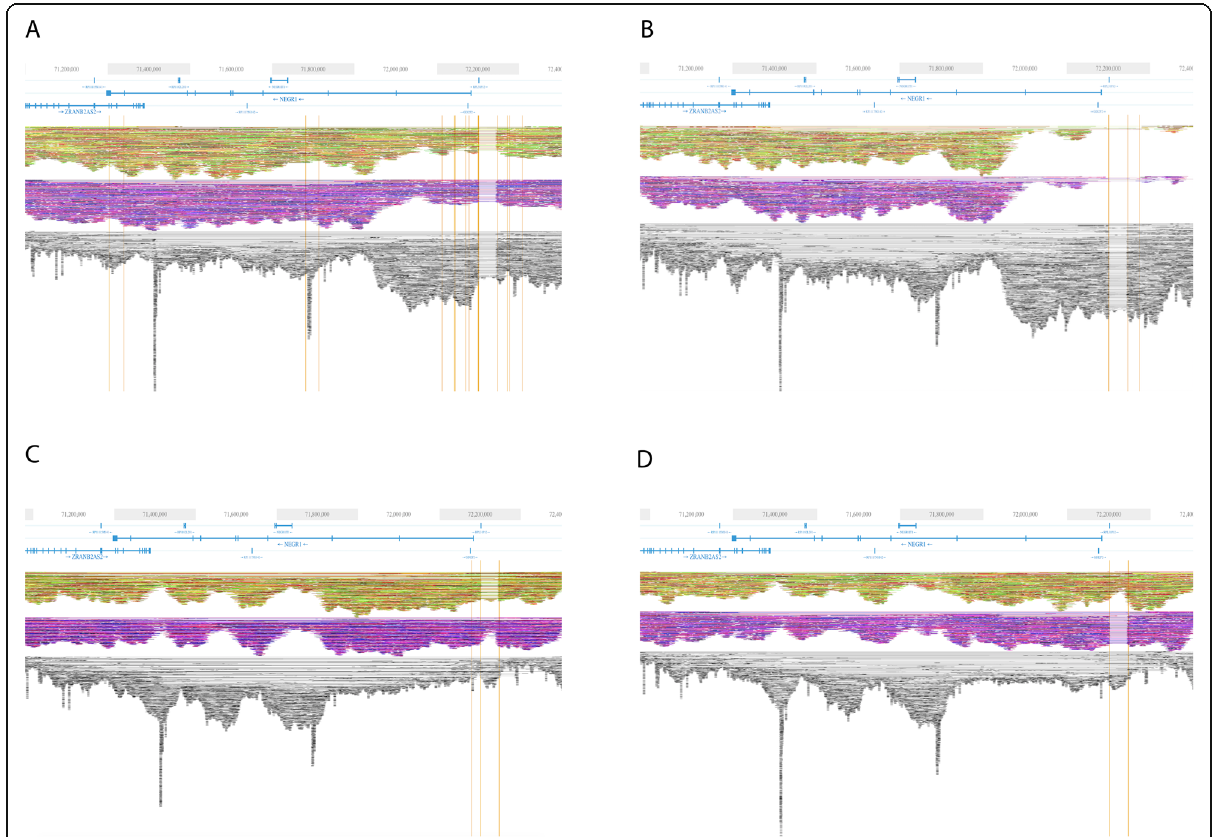
Fig. 1 Linked-read sequencing data for two pHGG patients at the NEGR1 locus. a . Homozygous NEGR1 deletion in the tumor profile of patient 6 (G641). b . Homozygous deletion in the germline of patient 6 (G641B). c . Heterozygous NEGR1 deletion in the tumor profile of patient 1 (SM2932). d . Heterozygous deletion in the germline of patient 1 (SM2819). In all panels, linked-reads are organized in haplotype blocks. Each haplotype is color-coded (green/yellow or pink/purple). Unassigned linked-reads are shown in back/gray at the bottom of each